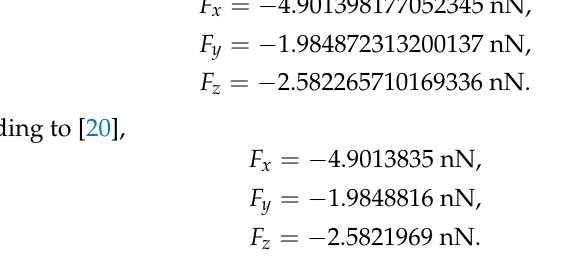
Figure 4. Two perpendicular circular loops. Singular case, a = c = 0, l = 0. F x = − 4.901398177052345